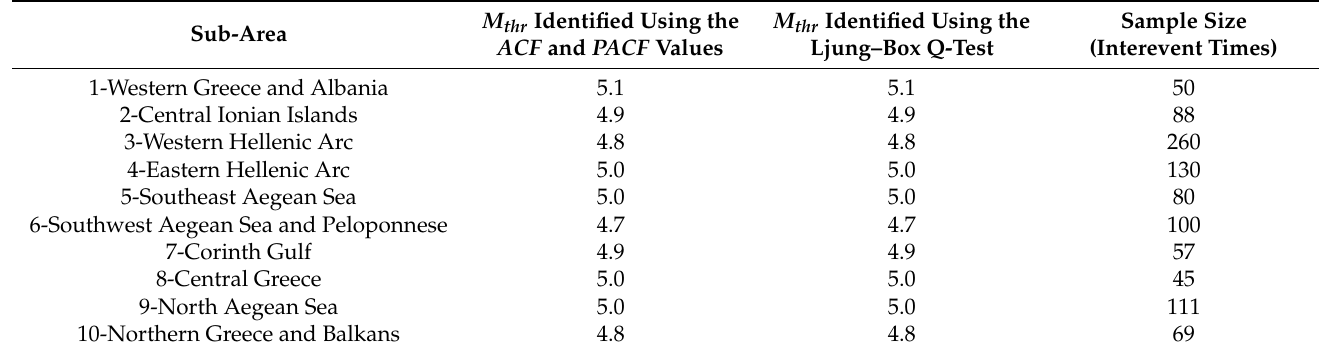
Table 2. Summary of the identification of the magnitude threshold ( M thr ) above which interevent time data, ∆ T , are statistically independent for the 10 sub-areas of the broader Aegean region. M thr Identified Using the M thr Identified Using the Sample Size Sub-Area ACF and PACF Values Ljung–Box Q-Test (Interevent